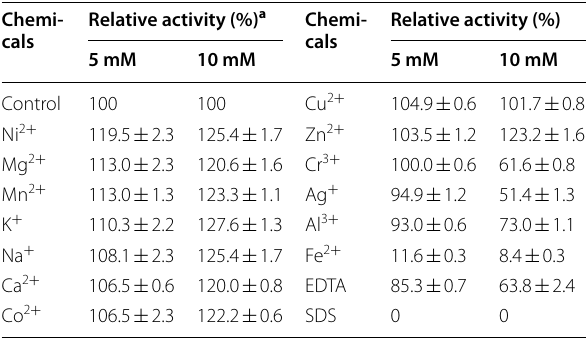
a Values represent mean